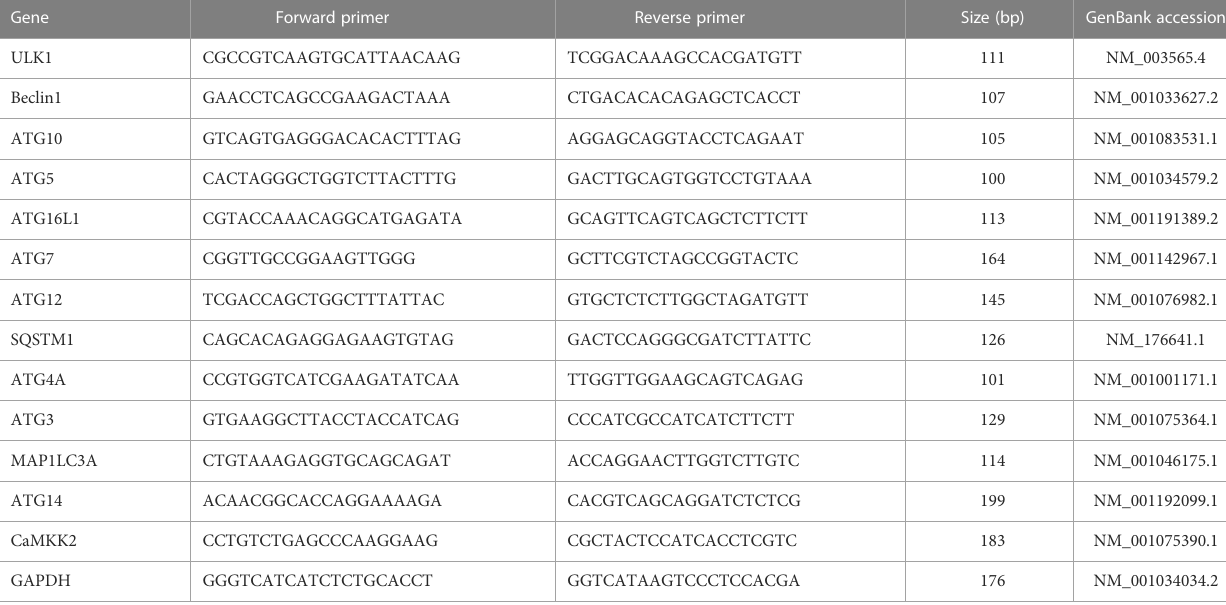
TABLE 2 Primers used in quantitative real-time PCR analysis.